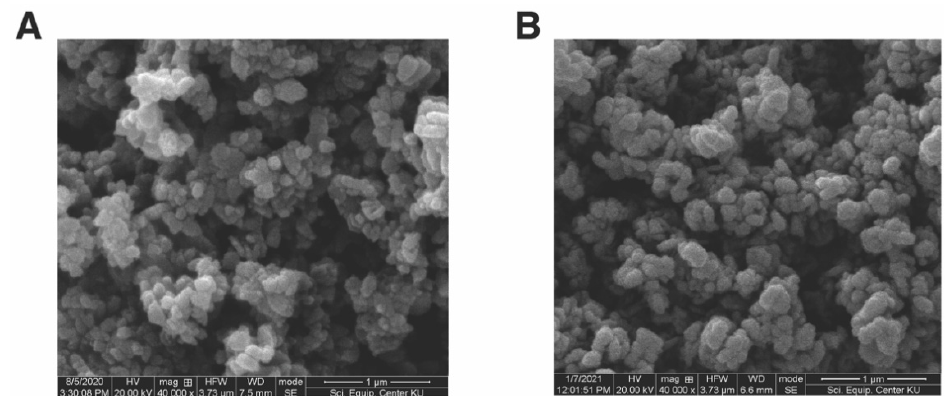
Figure 4. SEM images of synthesized ZnO NPs. ( A ) ZnO-Gm (mangosteen peel extract) and ( B ) ZnO-Ec (water hyacinth).